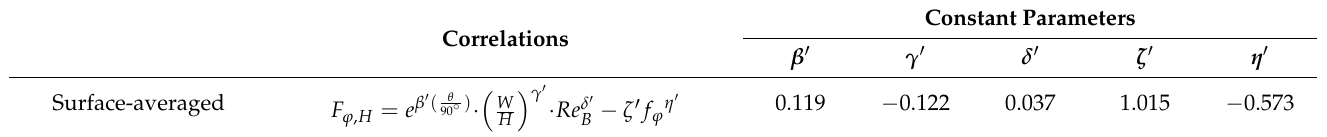
Table 6. Calculation for F ϕ , H to describe the wind direction effect on Nu at the louvered façade.